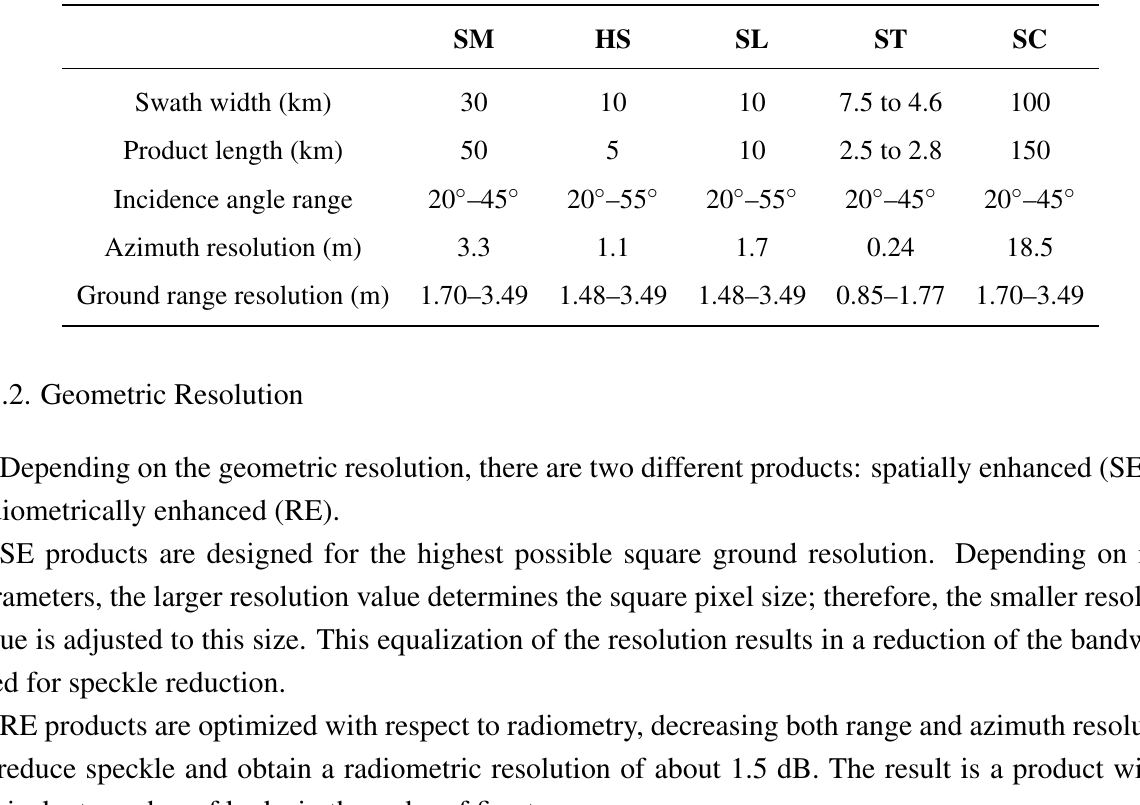
Table 1. Imaging modes of TerraSAR-X [26]. Stripmap (SM), high resolution spotlight (HS), spotlight (SL), staring spotlight (ST) and ScanSAR (SC).